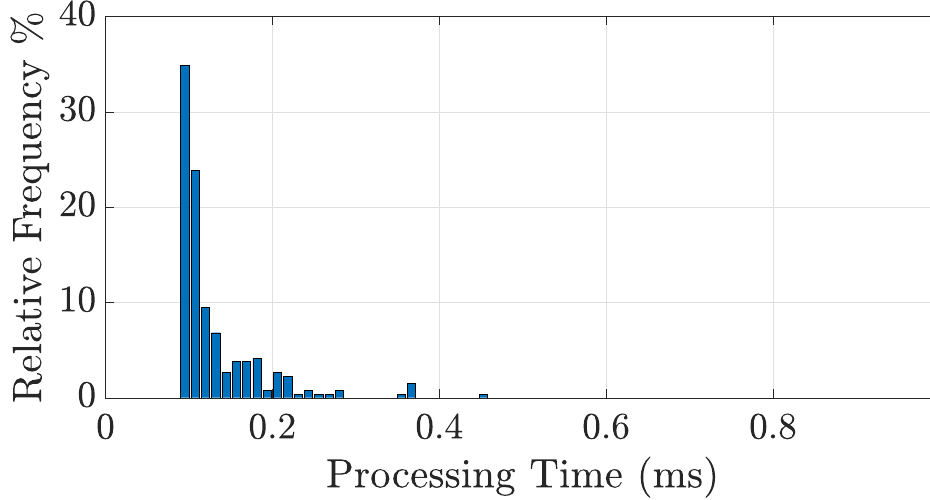
Figure 15. Histogram of the processing time (ms) for the N T = 264 analyzed